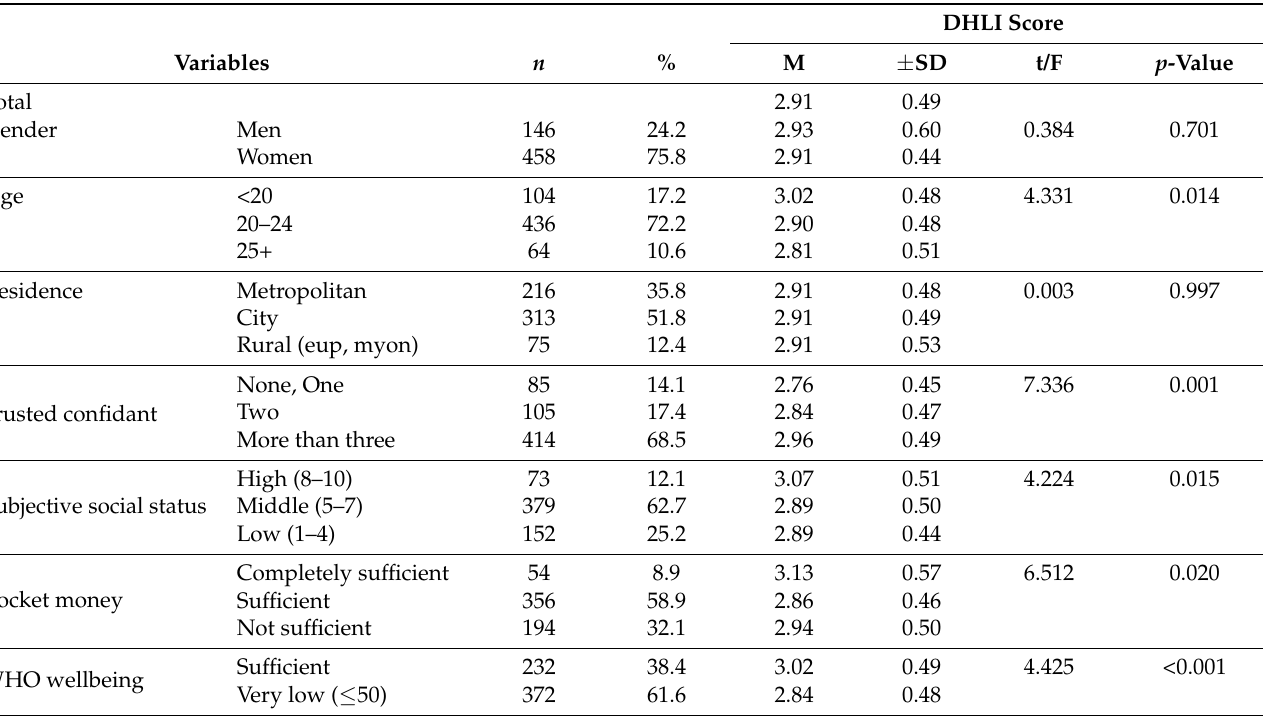
Table 1. General characteristics and group comparisons in the mean of total digital health